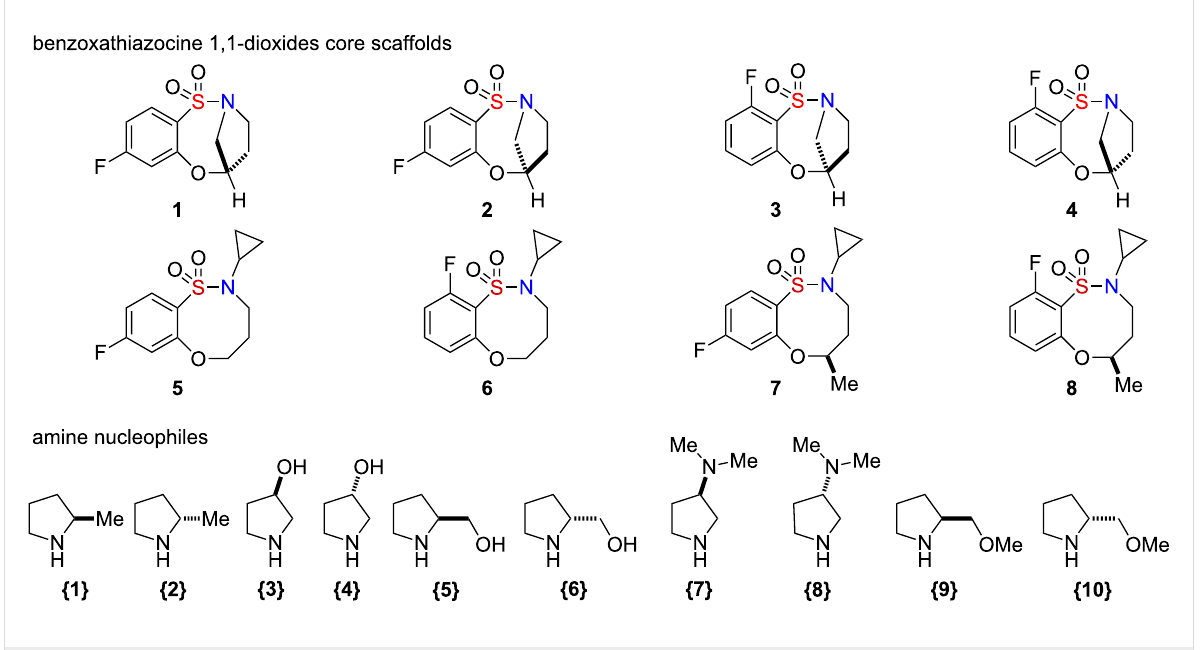
Figure 2: Benzoxathiazocine 1,1-dioxides 1 – 8 and amine library building blocks {1 – 10}